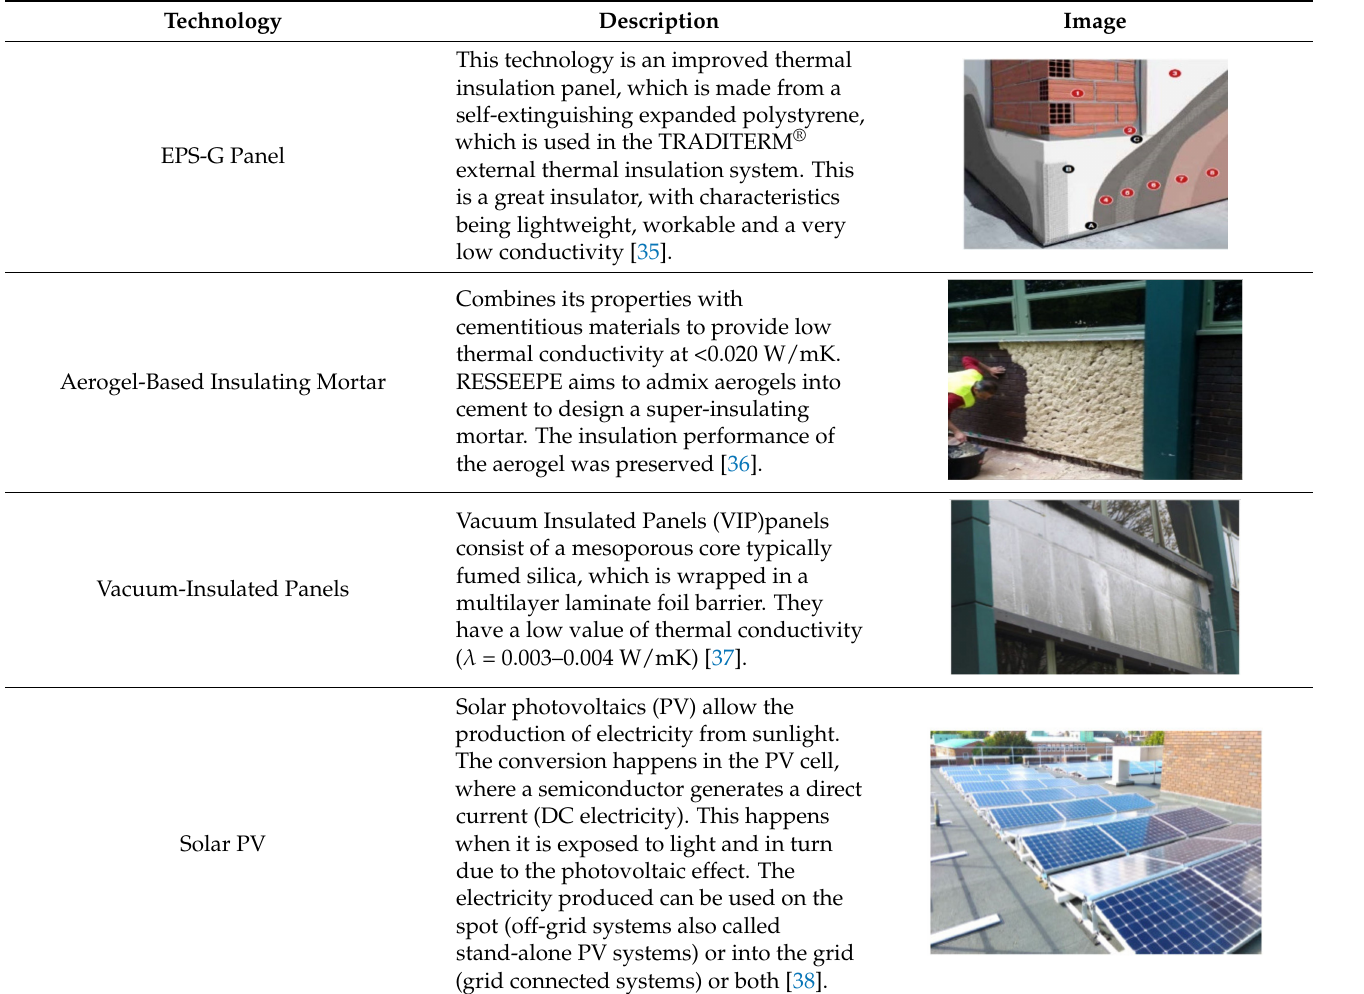
Table 3. Summary of materials and